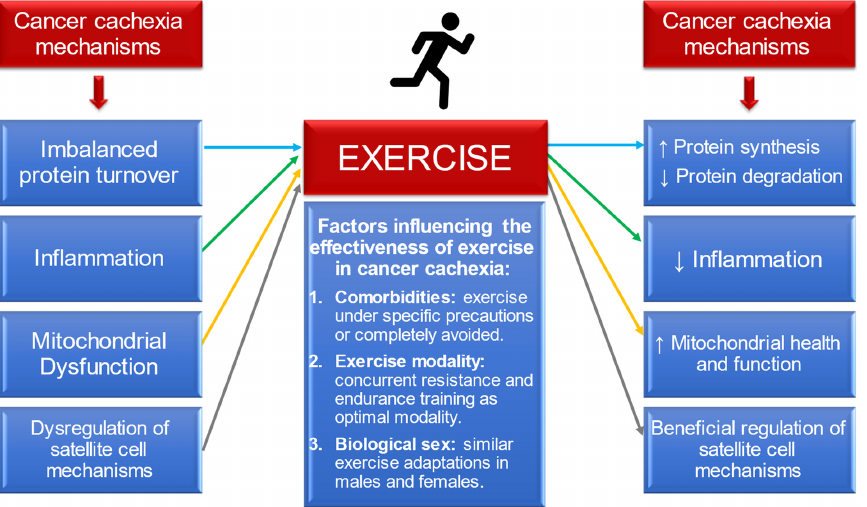
Figure 2. Schematic summary of the review: effects of exercise training in the major mechanisms of cancer cachexia (protein turnover, inflammation, mitochondrial function and satellite cell regula- tion); and the influence of cancer comorbidities, exercise modality and biological sex in the effec- tiveness of exercise training in cancer cachexia. Supplementary Materials : The following supporting information can be downloaded at: www.mdpi.com/xxx/s1, Table S1: Ongoing clinical trials with exercise-based interventions in cancer patients (source: https://clinicaltrials.gov). Author Contributions: S.T. and N.P.G. conceived and designed research; S.T. drafted manuscript; S.T., K.A.M., T.A.W. and N.P.G. edited and revised manuscript; S.T., K.A.M., T.A.W. and N.P.G. All authors have read and agreed to the published version of the manuscript. Funding: This study was supported by the National Institute of Arthritis and Musculoskeletal and Skin Diseases of the National Institutes of Health Award No. R01AR075794-01A1/AR/NIAMS (to N.P.G). Acknowledgments: Figure 1 was generated using BioRender. Conflicts of Interest: The authors declare no conflicts of interest. References 1.